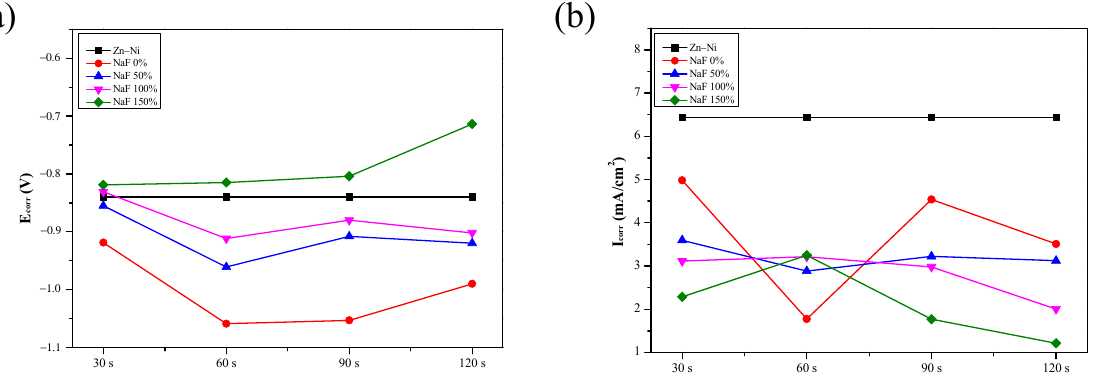
Figure 3. Potentiodynamic Tafel slopes of Zn–Ni alloy trivalent chromium coatings at various NaF concentrations ( a ) potential, ( b ) current density.